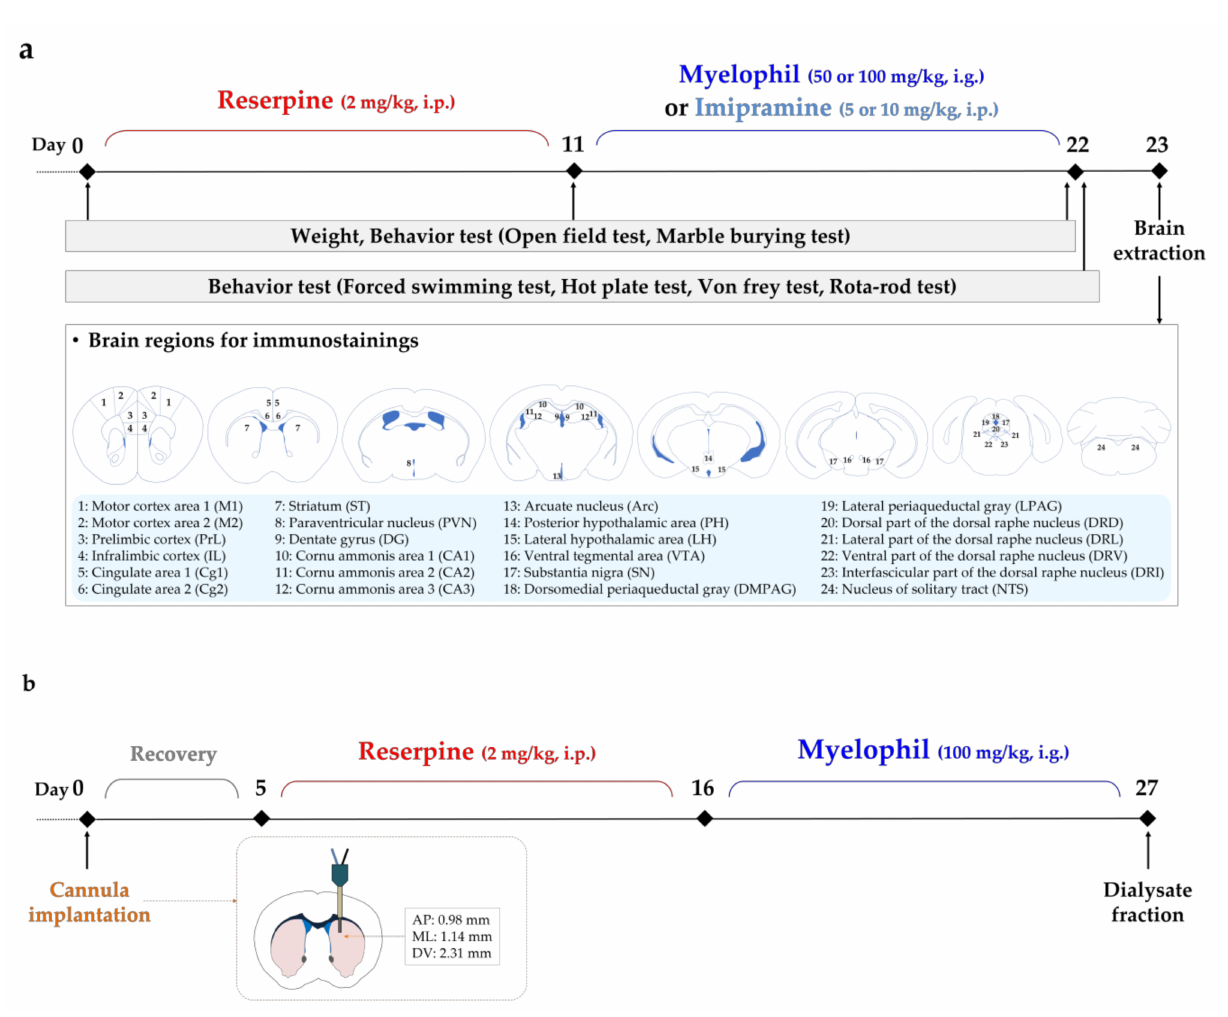
Figure 1. Experimental schedules for behavioral tests and study of brain neuronal mechanisms. ( a ) Schedule for drug administration of reserpine (2 mg/kg, i.p., 10 days), imipramine (5 or 10 mg/kg, i.p., 10 days), and myelophil (MYP: 50 or 100 mg/kg, i.g., 10 days); behavior tests for depression, pain, and fatigue symptoms; and brain extraction for immunostaining in reserpine-induced mice. ( b ) Schedule for microdialysis for conducting neurotransmitters. The cannula was implanted at the striatum (AP: 0.98, ML: 1.14, DV: 2.31 mm). After reserpine and MYP administration, dialysates were